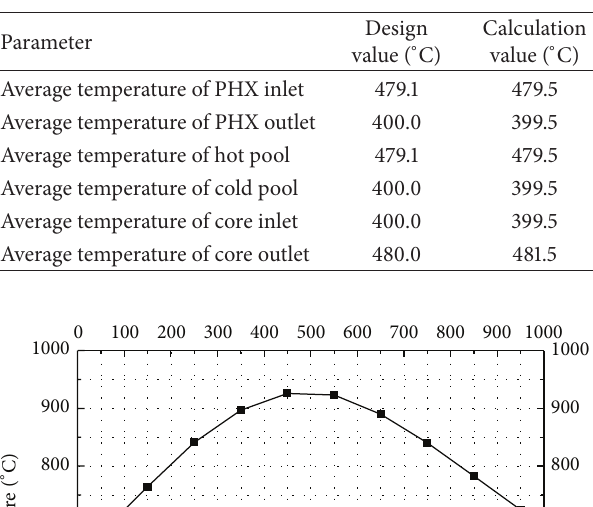
Table 5: Difference between SNRLFR-100 design values and calcu- lation results.